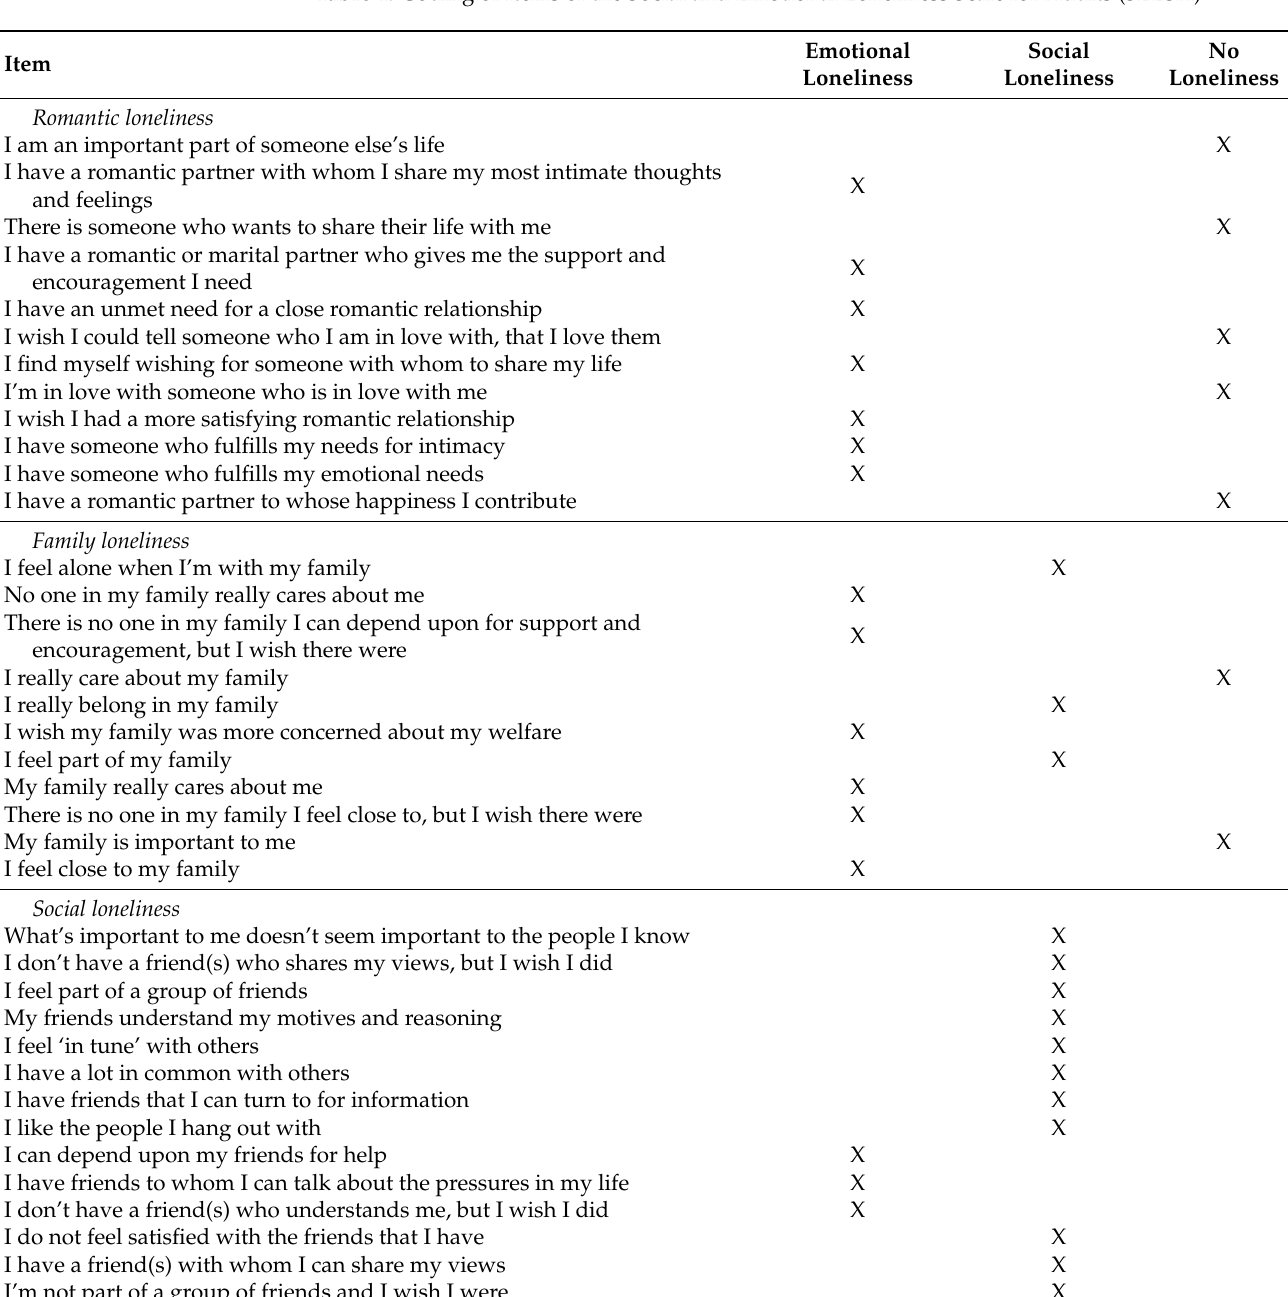
Table 4. Coding of Items of the Social and Emotional Loneliness Scale for Adults